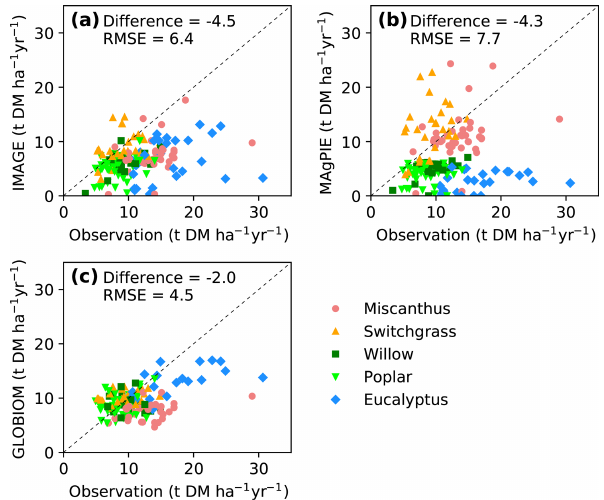
Figure 6. Comparison of yields from random-forest (RF) and IAM yield maps with site observations used to train the RF model (see the spatial distribution of sites in Fig. 1). Dashed lines indicate the 1:1 lines. The median differences and root-mean-square errors (RM- SEs) between site observations and yields from RF and IAMs are also